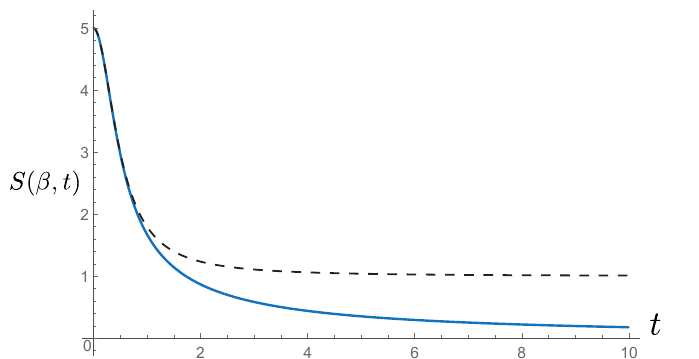
Figure 3. Spectral form factor (3.15) of N = 1 CJ supergravity at fixed β = 1 / 2 . The dashed and solid curves correspond to the perturbative (3.16) and exact (3.18) results respectively. The exact result decays to zero at late times, as expected from the continuous spectrum of O ( β ) in